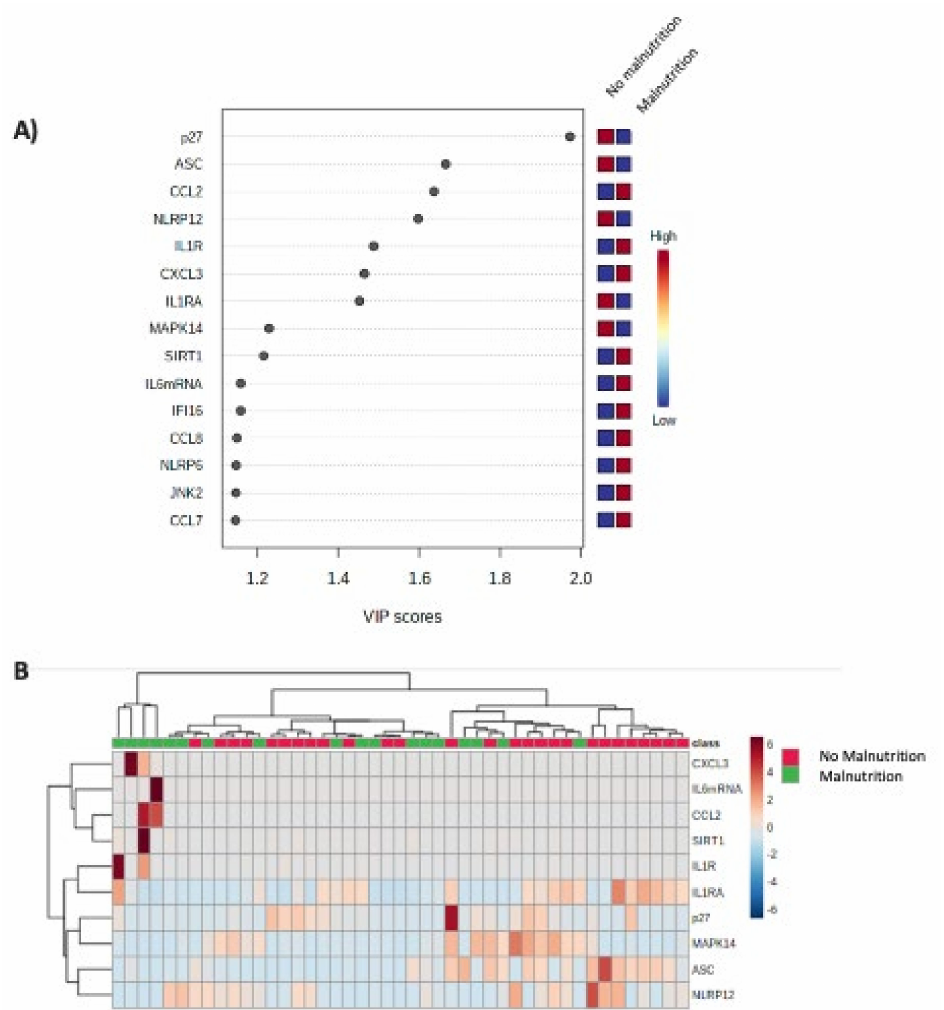
Figure 9. ( A ) VIP scores that summarize the contribution of the evaluated inflammasome components to discriminate patients with malnutrition (GLIM criteria); ( B ) Heatmap obtained with the expression levels of the components that better discriminate between patients with and without